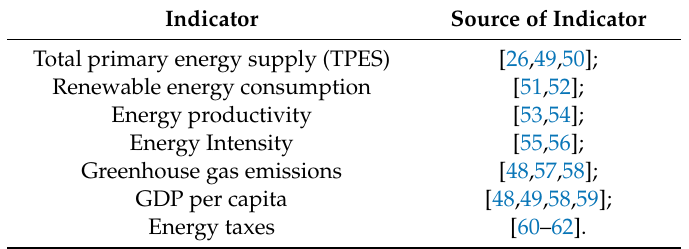
Table 1. The most popular indicators used to assess sustainable energy